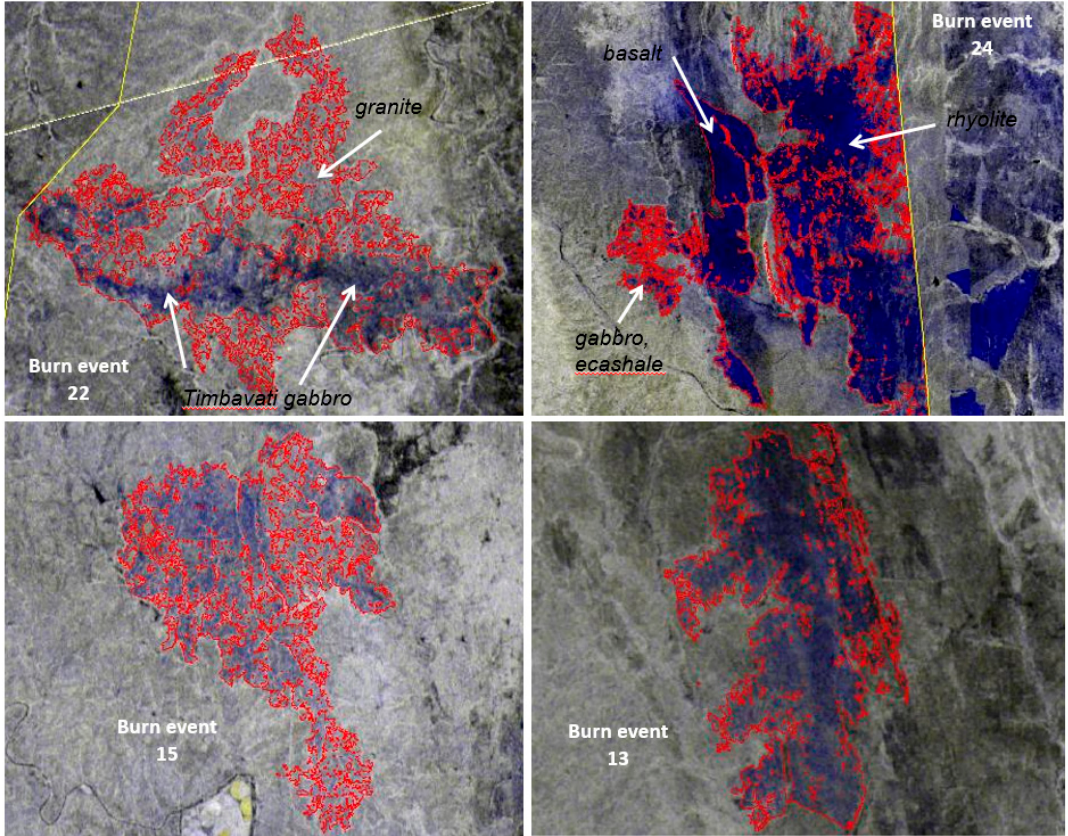
Figure 10. Sentinel-1 multi-date backscatter composites over four KNP burn events. The color channels are displayed as follows: Red layer = VH post-fire image; green layer = VH post-fire image; blue layer = VH pre-fire image. Grey shades indicate small or no backscatter intensity changes between the two Sentinel-1 acquisition dates (from black, low backscatter to white, high backscatter). Blue shades indicate backscatter decrease between the pre-fire and the post-fire image, with the intensity indicating the magnitude of the decrease (faint blue = low decrease and vivid blue = high decrease). Red boundaries show the extracted Landsat burned areas and yellow lines show the KNP boundary. The mean pre-fire to post-fire backscatter differences, and median day, for these burn events—labelled as: burn 22 (early season fire) Woodlands on granite (north) and grasslands on Timbavati gabbro (south); burn 24 (early season fire) East–west gradient moderately dense woodland (gabbro), grassland (basalt), and moderately dense woodland (rhyolite); burn 15 (main season fire) Moderately dense woodlands on granite, burn 13 (main season fire) Grassland (basalt)—are shown in Figure 8.